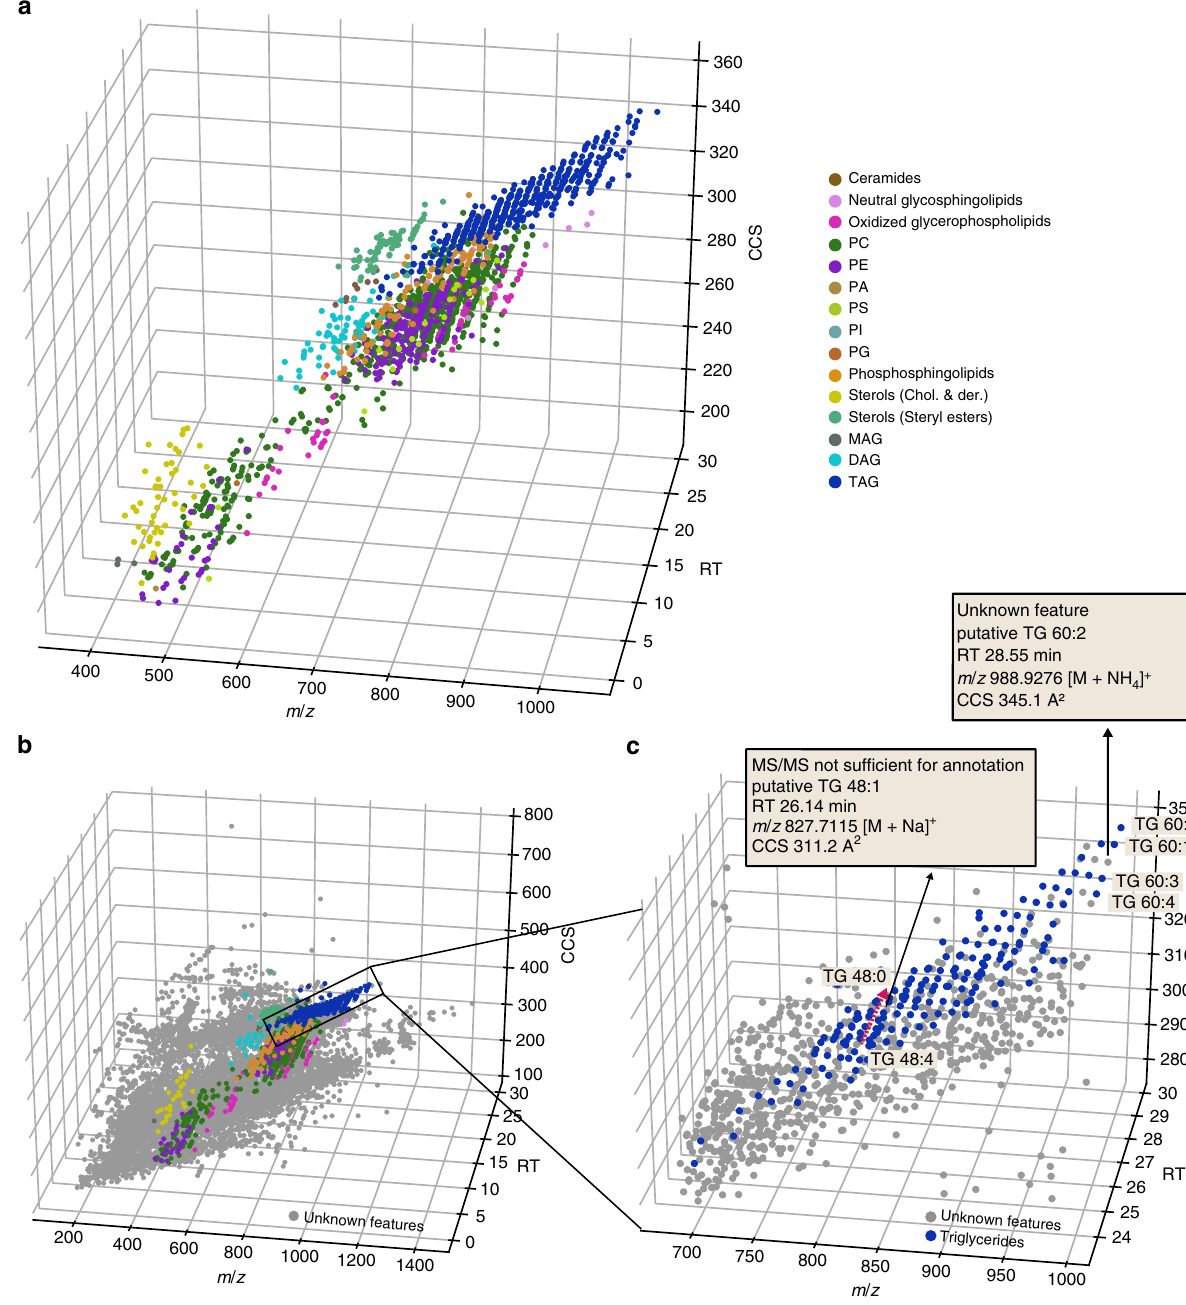
Fig. 6 The conformational landscape of lipid ions in TIMS. a Three-dimensional (RT, m/z , CCS) distribution of 1856 lipids from various classes from three biological samples (plasma, liver, HeLa) in positive ion mode. b Overlay of unidenti fi ed (gray) and identi fi ed MS features detected in a human plasma sample. c Zoom into the data cuboid and putative assignment of two previously unidenti fi ed lipids based on their relative position in the data space. PC = Phospatidylcholine, PE = Phospatidylethanolamine, PA = Phosphatidic acid, PI = Phospatidylinositol, PG = Phospatidylglycerol, PS = Phospatidylserine, MAG = Monoacylglycerol, DAG = Diacylglycerol, TAG =